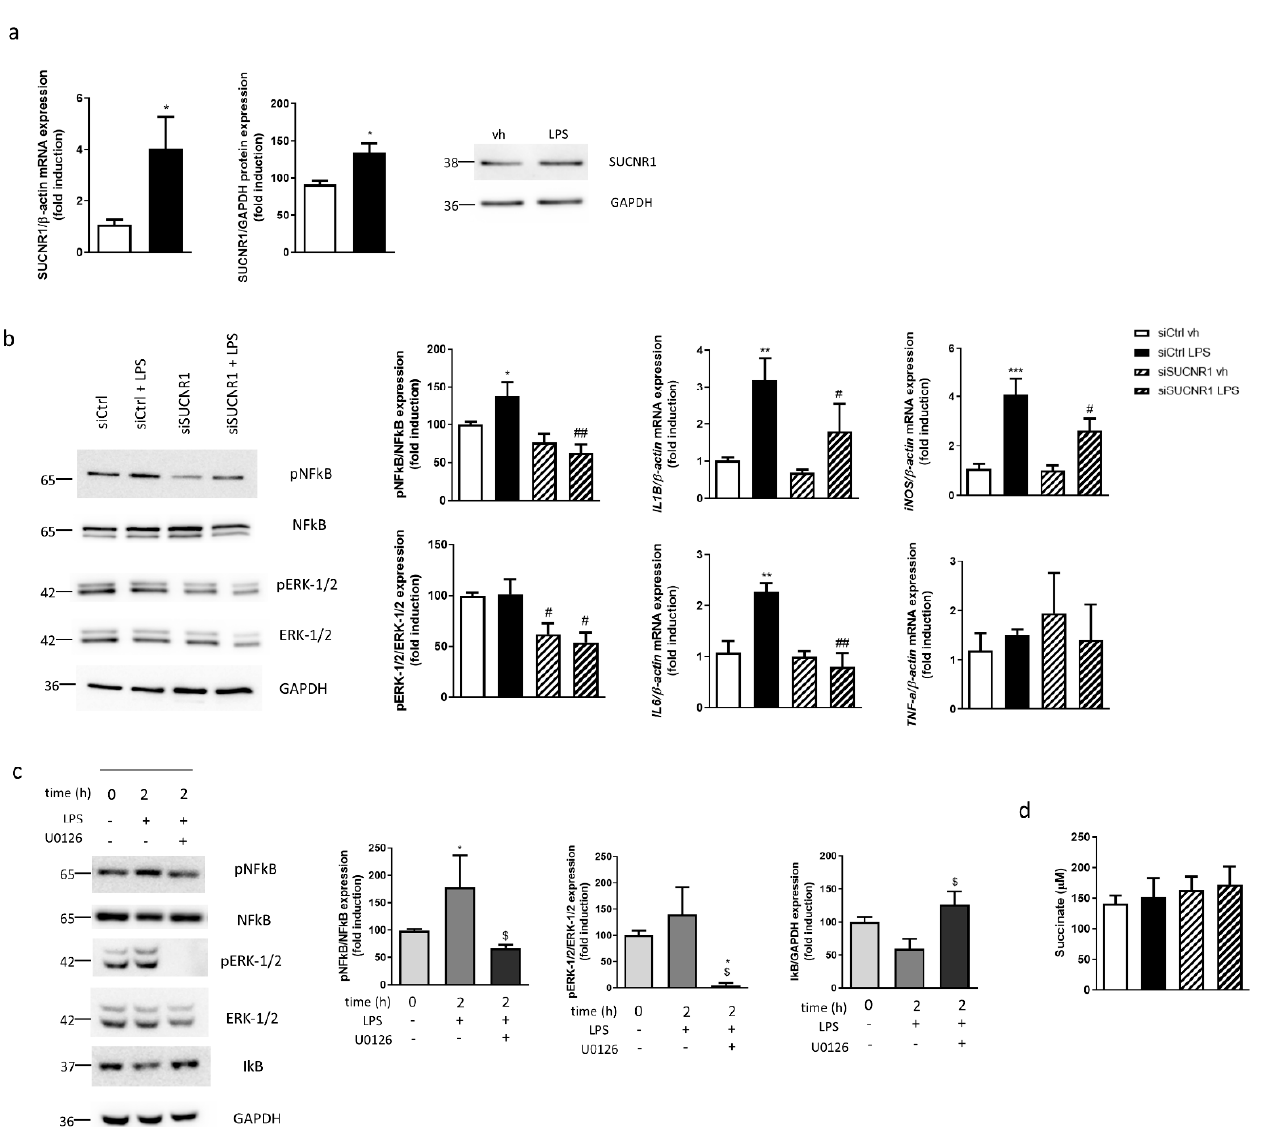
Figure 2. SUCNR1 mediates basal and LPS-stimulated inflammatory pathways in intestinal epithelial cells. ( a ) HT29 cells treated with LPS 0.1 µ g/mL during 24 h and graphs show mRNA and protein ( b ) HT29 cells transiently transfected with a specific siRNA against SUCNR1 or ctrl and treated